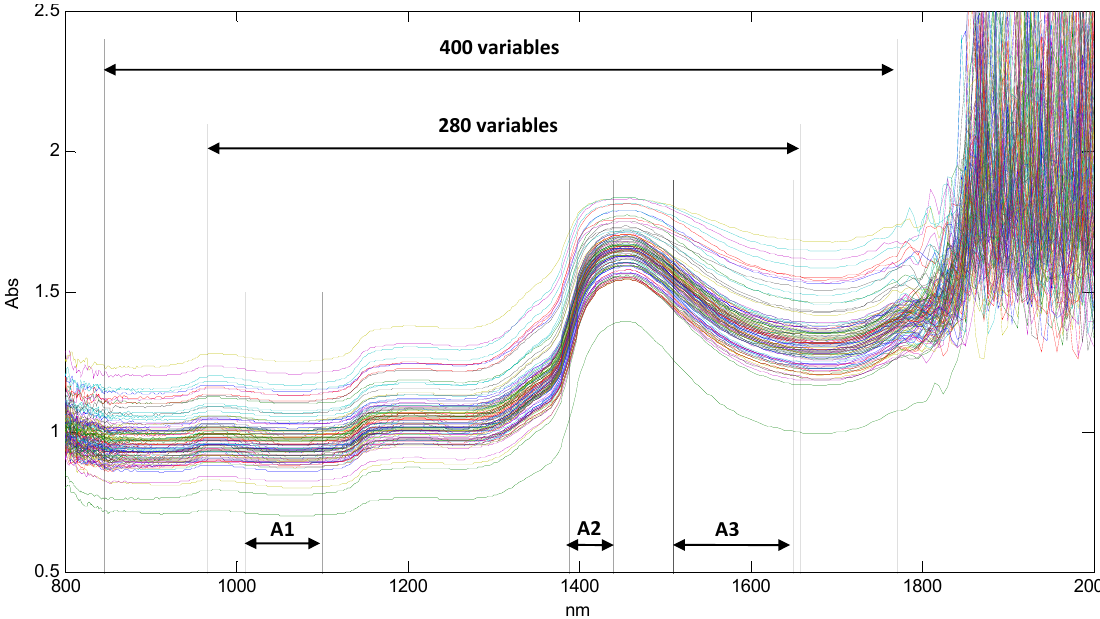
Figure 2. Spectral regions used for developing the models. A1, A2 and A3 represent the regions associated with the NH 4+